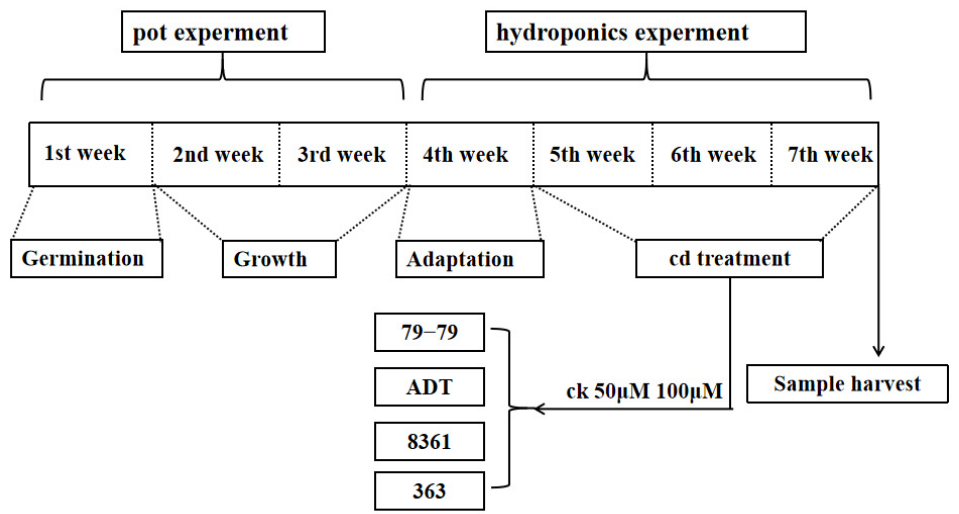
Figure 1. Scheme of the used treatments to study the effect of cadmium (Cd) toxicity in the sunflower varieties.